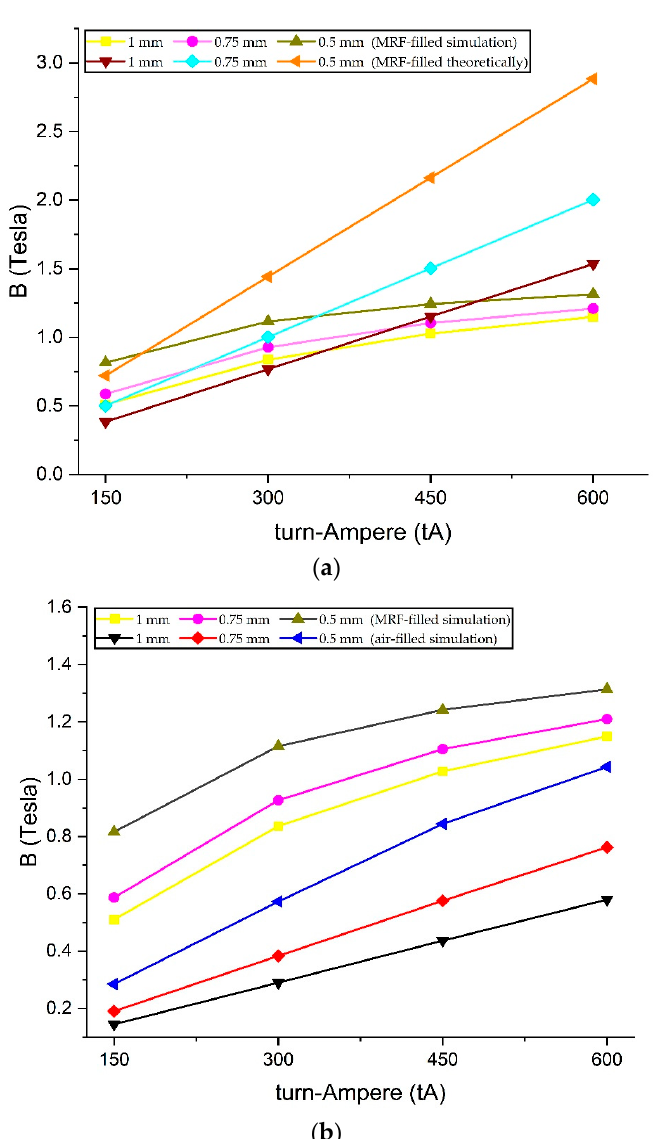
Figure 13. Comparison of magnetic flux density: ( a ) Fourth scenario vs fifth scenario; ( b ) Second scenario vs fifth scenario.